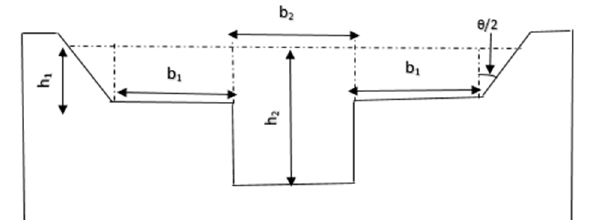
Fig. 4: Compound Rectangular-Trapezoidal Sharp-Crested Weir The desired flow rate used in experiments was adjusted by varying over the weir. The values of discharges were calculated by Equation (1) of Compound rectangular-trapezoidal sharp-crested weir [22].The discharge values are shown in Table 1.